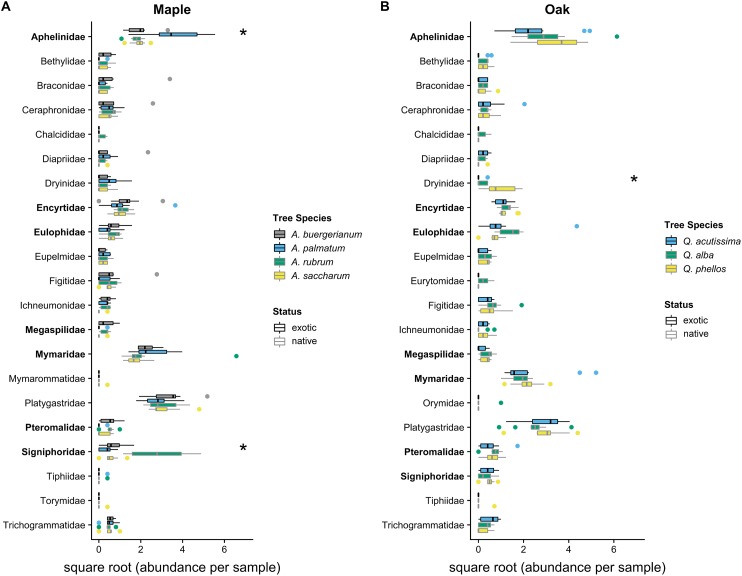
2016 parasitoid wasp communities.Abundance of parasitoid wasps per 7-day sampling period in 2016 on (A) maples and (B) oaks. Colored boxes mark the interquartile range (IQR), and whiskers extend to the largest value within 1.5 * IQR. Values beyond 1.5 * IQR are marked as points. Exotic species are outlined in black. Parasitoid families that differed significantly between tree species in univariate tests are marked with * (Tables S3 and S4). Parasitoid wasp families that use scale insects as hosts (Kosztarab, 1996) are bolded on the y-axis. Global tests indicated significant differences in the parasitoid wasp communities of maples and oaks (p < 0.05), where all maple species had different communities and Q. phellos had a different community than the other two oak species (Tables S3 and S4).